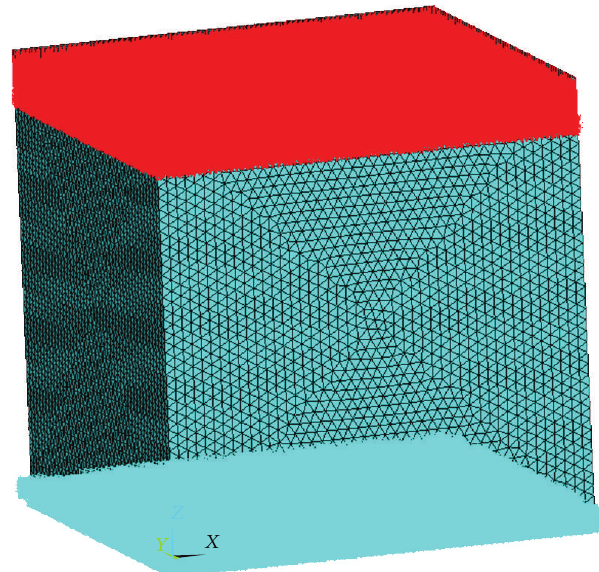
Figure 3: Applied compressive loading distributed over the top surface (shown in red) and bottom surface fixed for all degrees of freedom (shown in blue) on a typical porous cubic model subjected to compressive loading